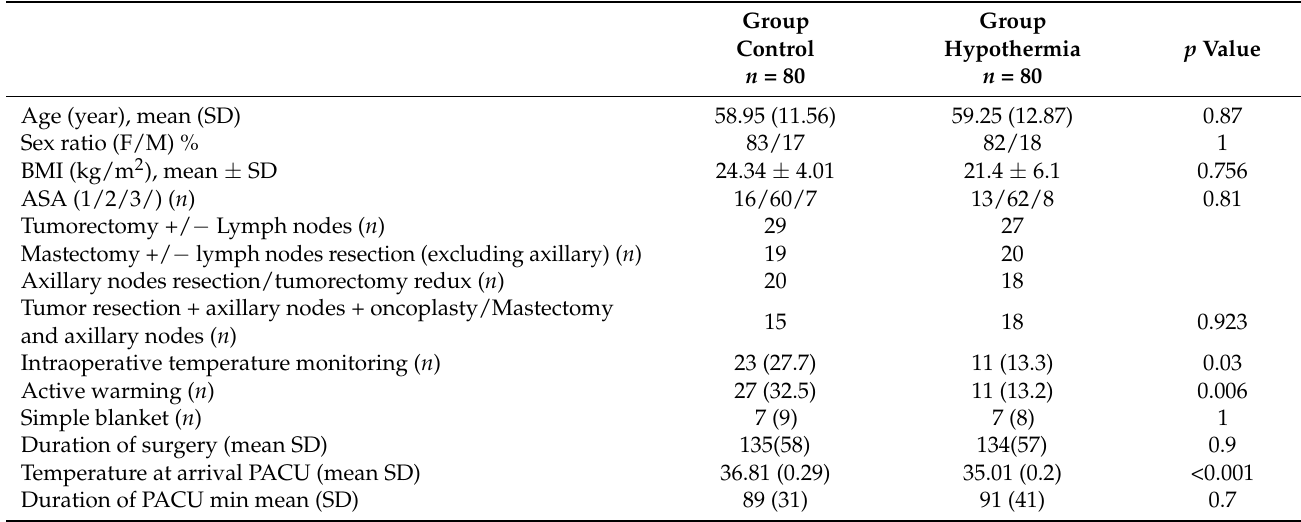
Table 1. Patient characteristics comparison after matching.